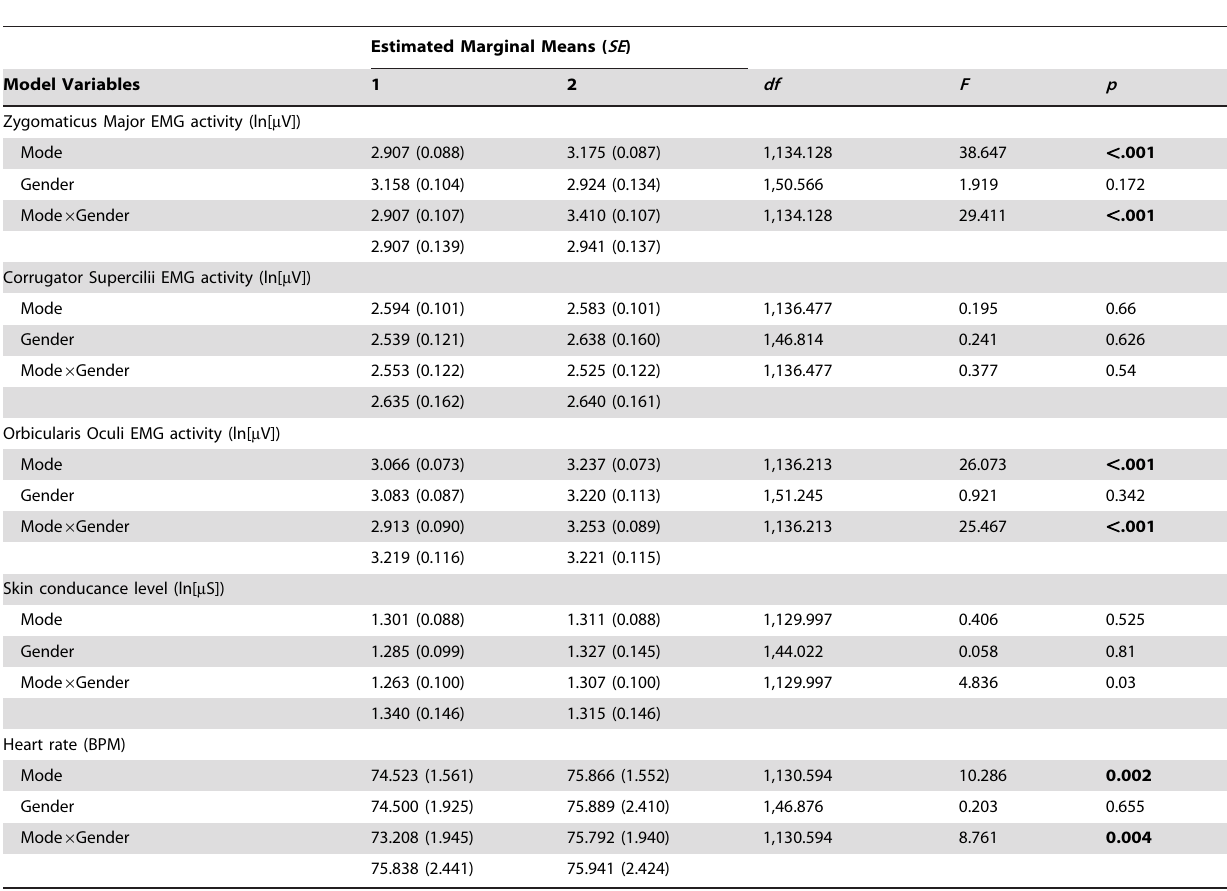
Table 1. Experiment 1 Linear Mixed Models for Physiological Dependent Variables.